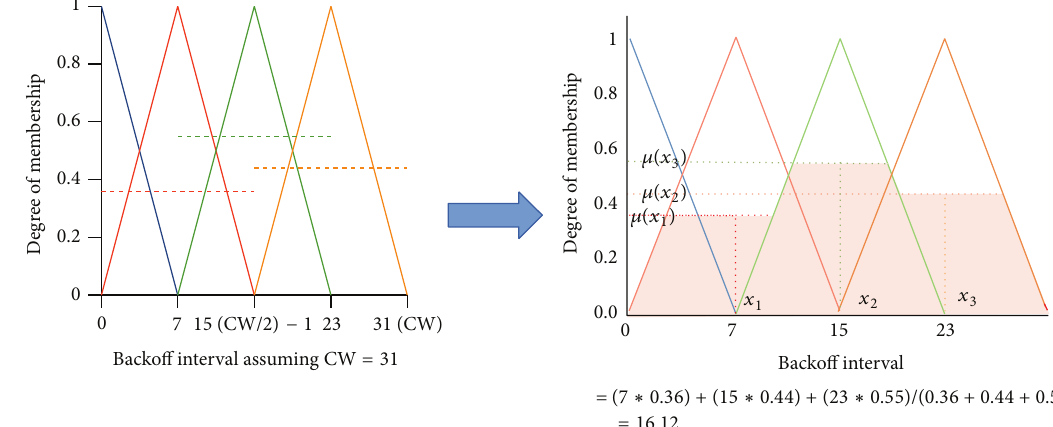
Figure 7: Aggregating the result of Rules with centroid method.